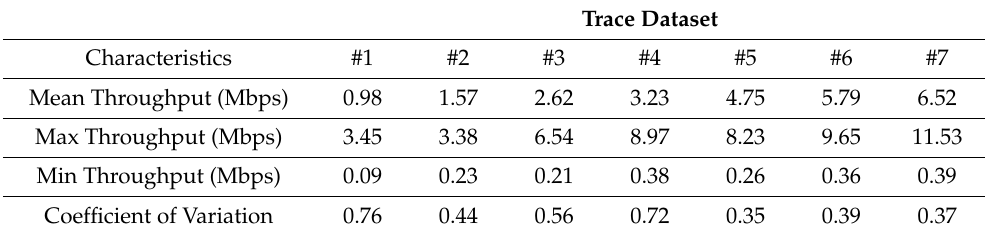
Table 2. Throughput information of network datasets.